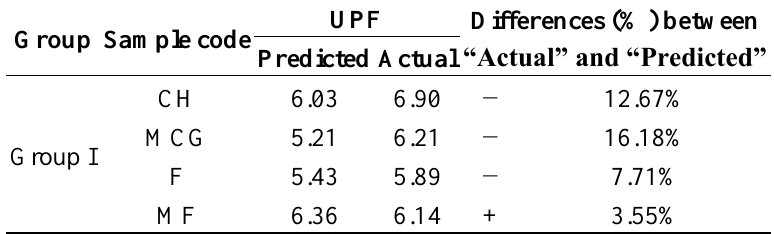
Table 5. Difference (%) between “Actual” and “Predicted” of UPF